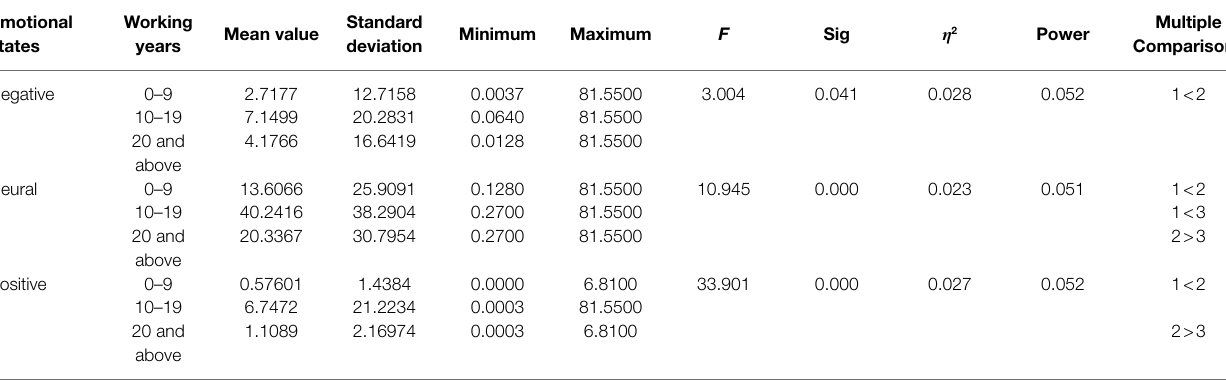
TABLE 10 | One-way ANOVA results for perception level at different working